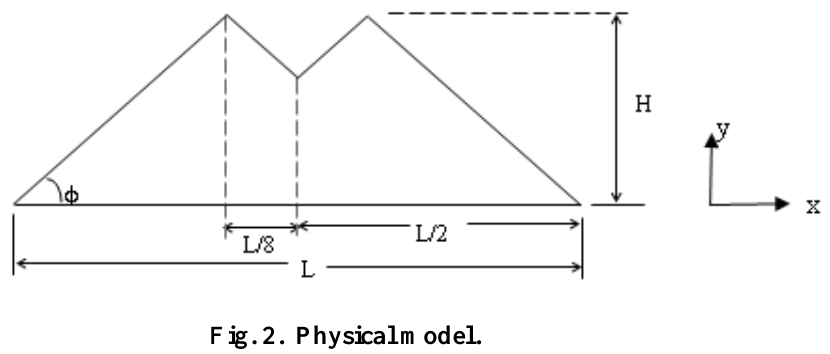
Fig. 2. Physical model.